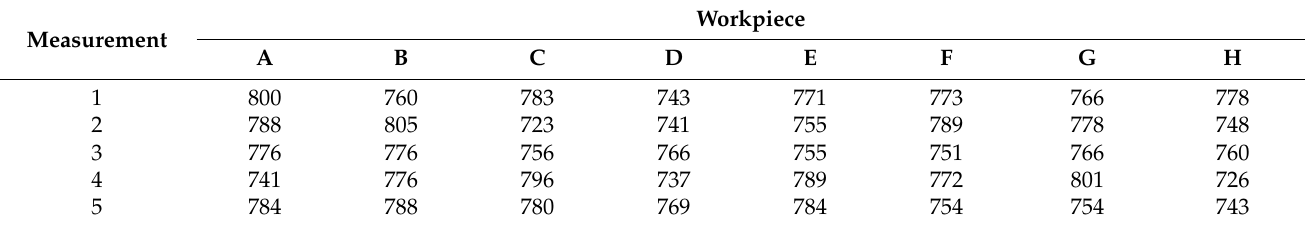
Table 3. Measured Vickers hardness values of the workpieces.